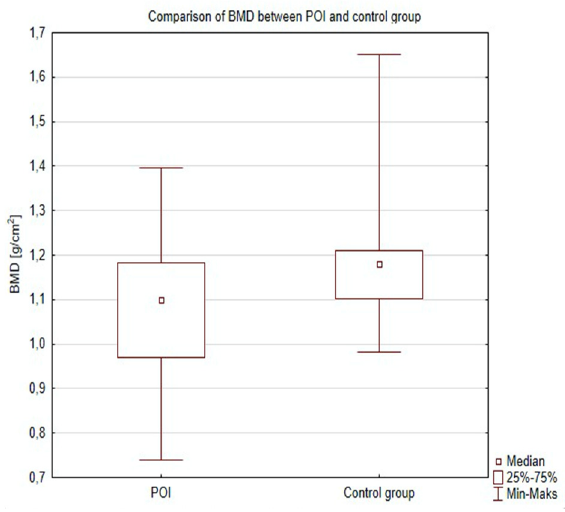
Figure 1. Comparison of BMD between POI and control group.